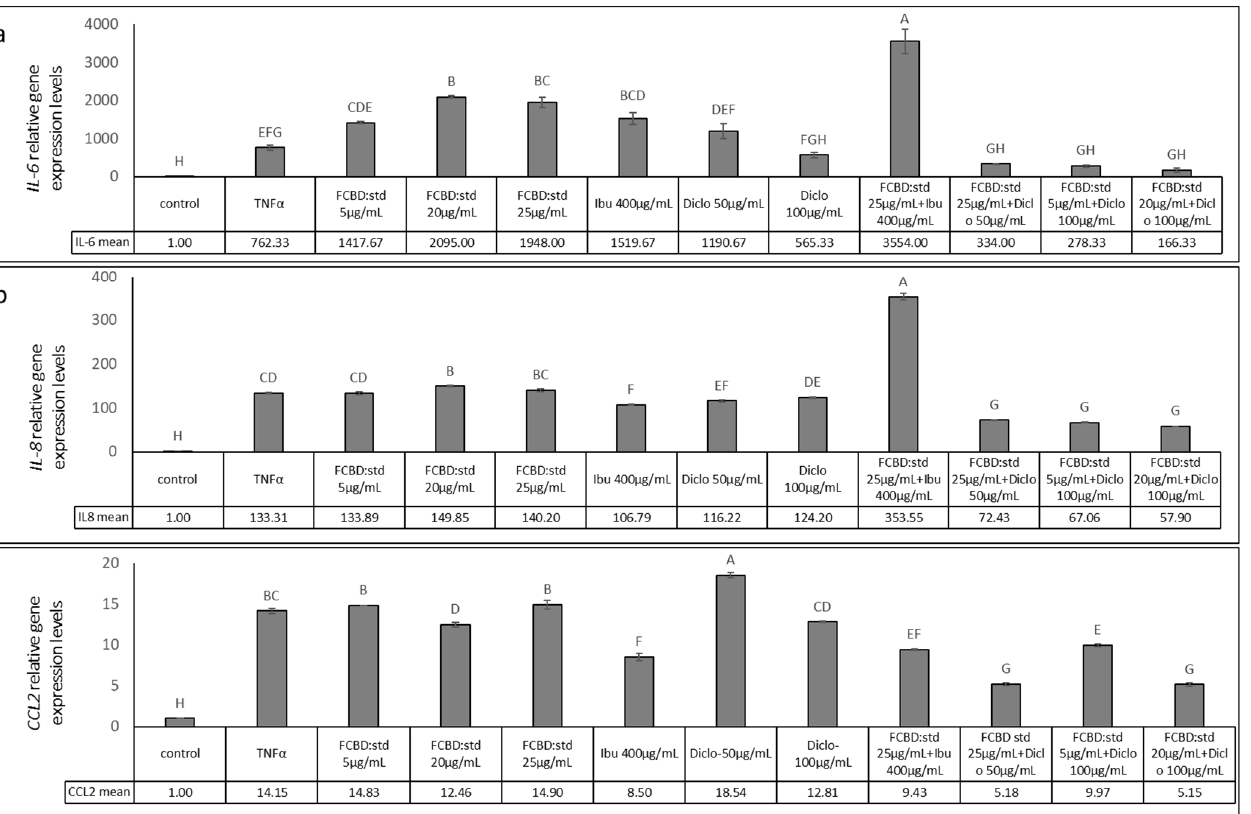
Figure 5. Determination of the RNA steady-state level using quantitative PCR-based in co-culture of A549 and differentiated KG1 cell line of ( a ) IL-6 , ( b ) IL-8 or ( c ) CCL2 after treatment for 2 h with FCBD:std or ibuprofen (Ibu) or diclofenac (Diclo) and their combinations, relative to control. Quantitative PCR determined gene transcript values as a ratio between the target gene versus β -actin as a reference gene. Using the 2 ΔΔCt method, values were calculated relative to the average expression of target genes in treated versus control . Control (1% methanol) treatment served as solvent (vehicle) control. TNFα is solvent control+TNFα. Means ± SE ( n = 3) are shown. Levels of means with different letters are significantly different from all pairs’ combinations according to Tukey–Kramer honest significant difference (HSD; p ≤ 0.05).